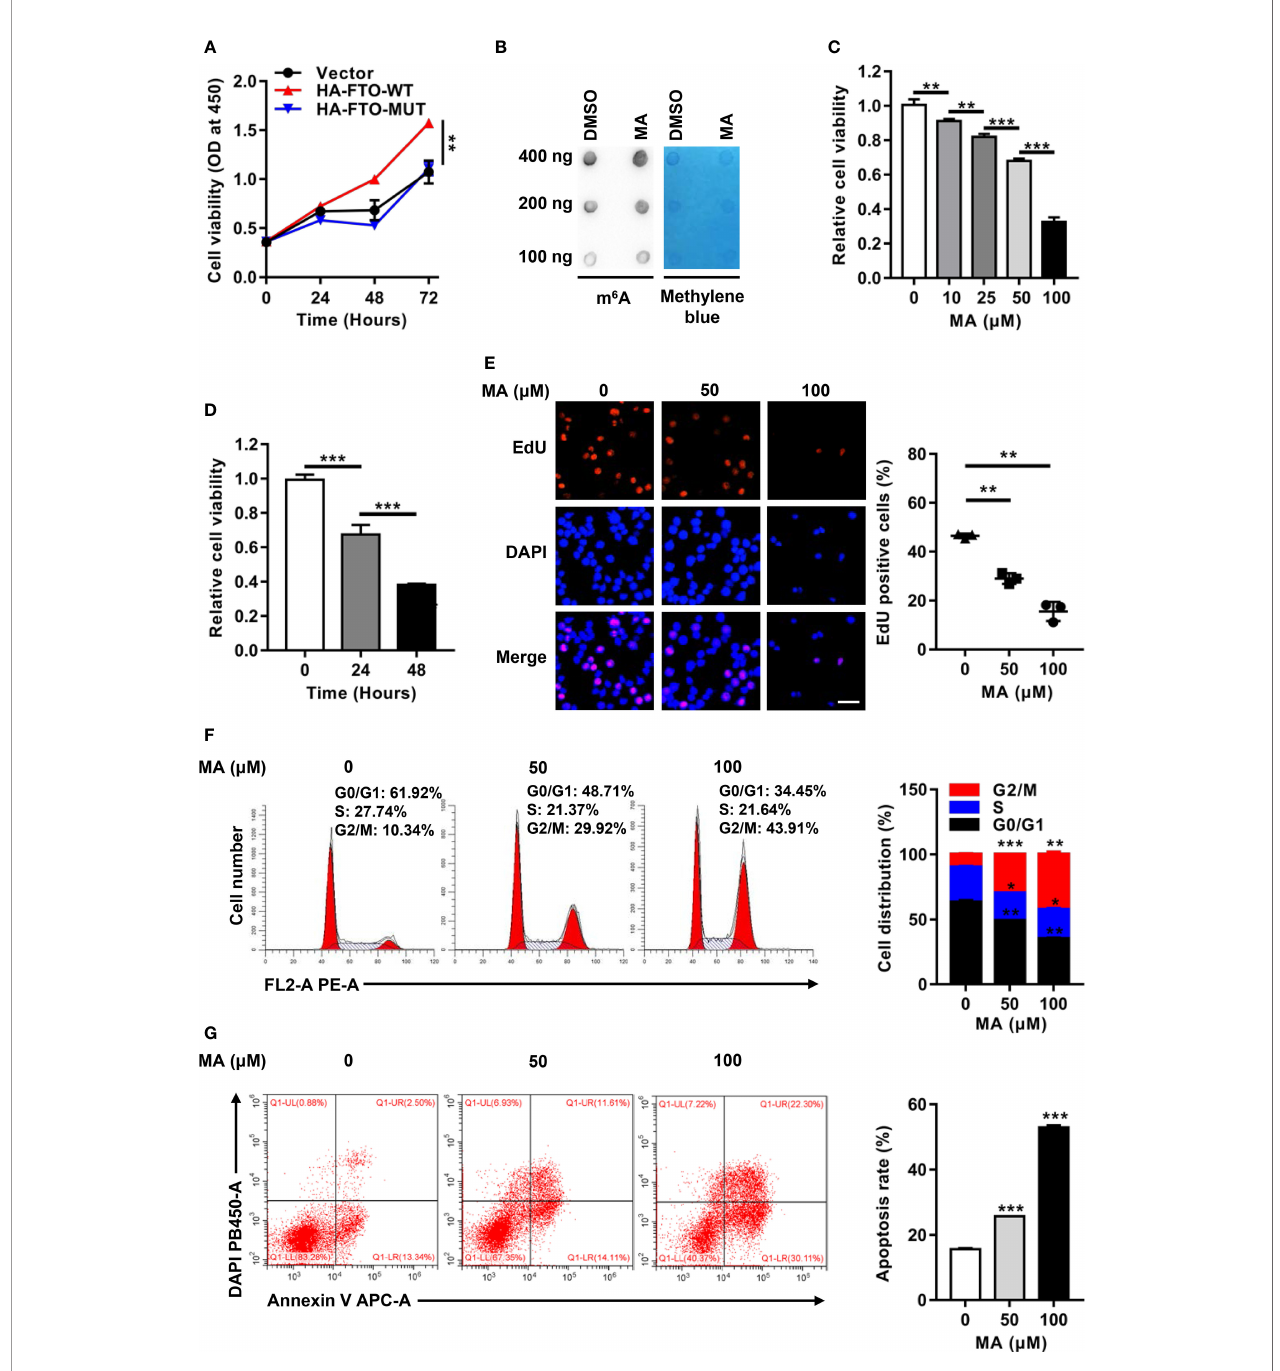
FIGURE 4 | The Oncogenic Function of FTO is Dependent on m 6 A RNA Demethylase Activity. (A) CCK-8 analysis of cell proliferation in OCI-AML3 cells following transfection of the HA-FTO-WT and HA-FTO-MUT plasmids. (B) m 6 A dot blot analysis of the m 6 A level of global RNAs in OCI-AML3 cells with MA or DMSO treatment for 24 h. Methylene blue staining served as a loading control. (C) Dose-dependent effect of MA on cell viability. CCK-8 analysis of cell proliferation in OCI- AML3 cells exposed to 0, 10, 25, 50, and 100 m M MA for 24 h. (D) Time-dependent effect of MA on cell viability. CCK-8 analysis of cell proliferation in OCI-AML3 cells exposed to 100 m M MA for 0, 24, and 48 h. (E) EdU analysis of cell proliferation in OCI-AML3 cells upon 50 m M and 100 m M MA treatments of 24 h. The bar graph showed the percentage of EdU positive cells. Scale bar: 50 m m. (F) Flow cytometric analysis of the cell cycle distribution in OCI-AML3 cells upon 50 m M and 100 m M MA treatments of 24 h. The bar graph showed the percentage of G0/G1, S, and G2/M phase cells. (G) Cell apoptosis was measured by fl ow cytometric analysis of the Annexin V/DAPI stained cells. The bar graph showed the cell apoptosis rate. Data were presented as the mean ± SD of three independent experiments. * P < 0.05, ** P < 0.01, *** P <